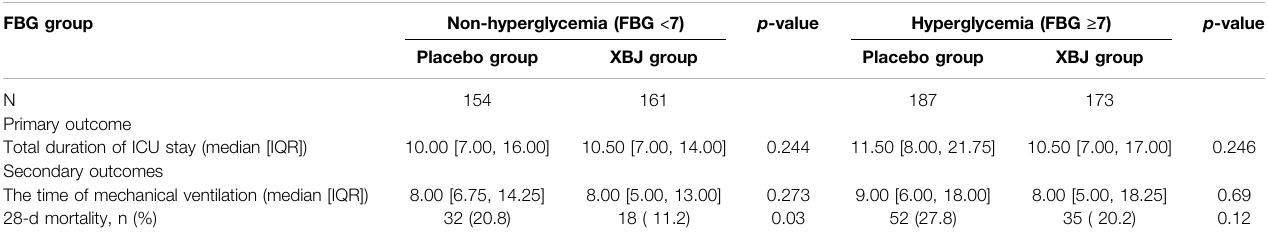
TABLE 6 | Primary and three secondary outcomes in the FBG